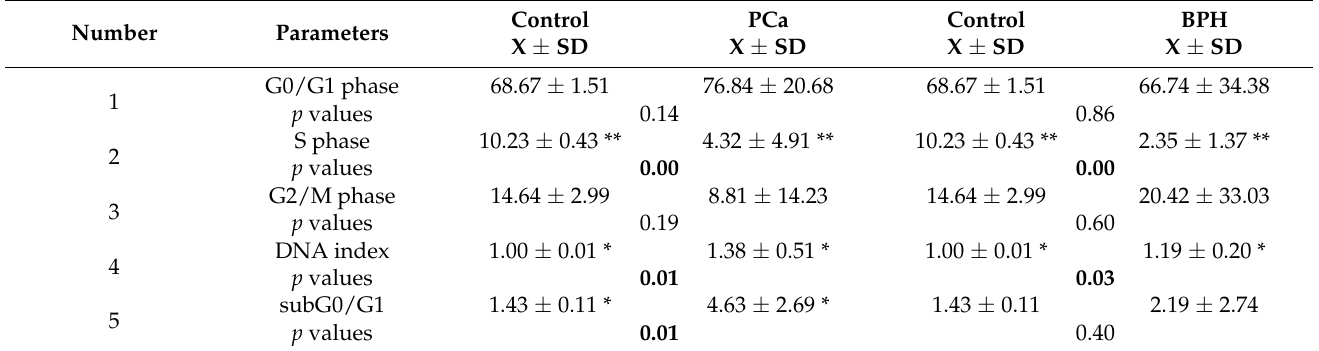
Table 1. Cell cycle phases, ploidy index, and DNA fragmentation at prostate adenocarcinoma, benign prostatic hyperplasia, and non-malignant adjacent tissue